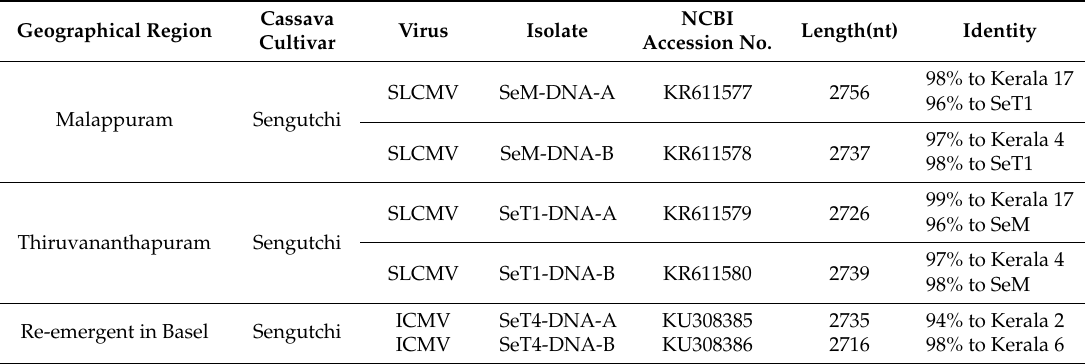
Table 1. Sri Lankan cassava mosaic virus (SLCMV) and Indian cassava mosaic virus (ICMV) isolates cloned from the Sengutchi variety of cassava plants collected from the fields of Malappuram (SeM) and Thiruvananthapuram